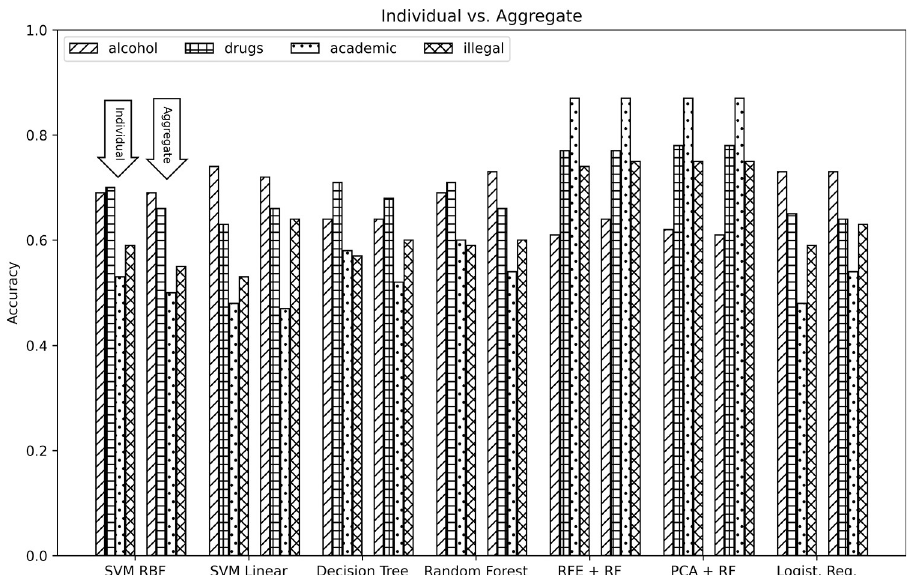
Fig 1. Comparing aggregate and individual FoMO item performance metrics. Comparison of model accuracy for the aggregate scenario vs. the individual scenario across behavior domains based on values shown in Tables 3 and 4. Results are aggregated by machine learning model and scenario, with solid bars representing accuracy values for the aggregate scenario and the bars with patterns showing the results for the individual scenario.